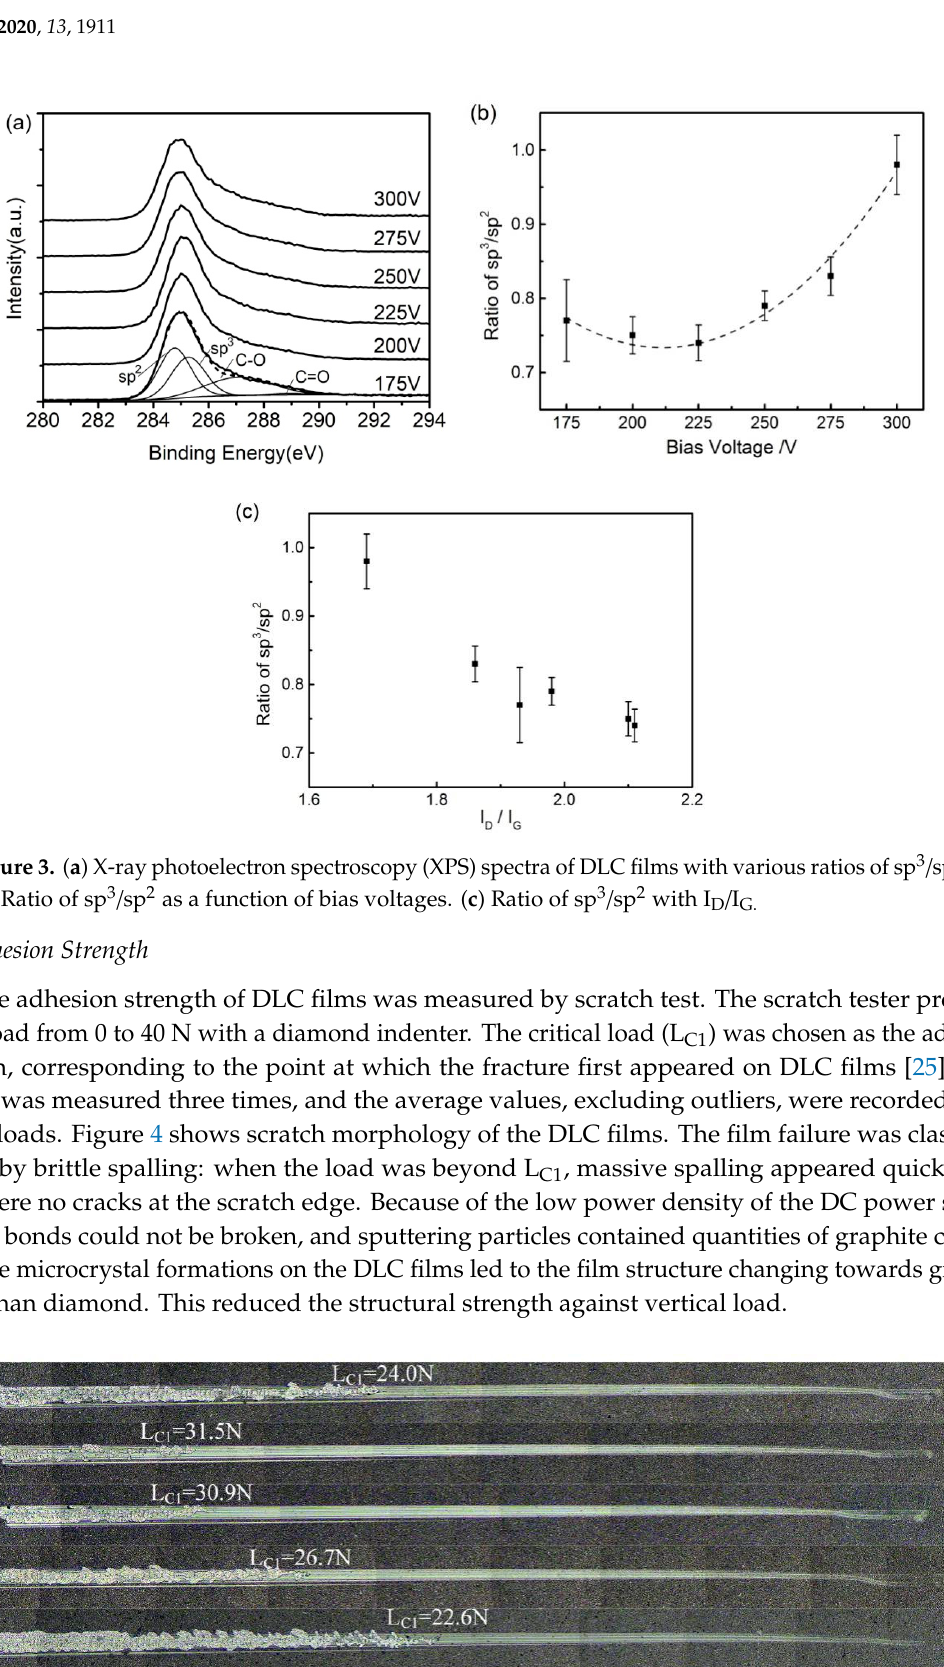
Figure 2. ( a ) Raman spectra of DLC films with various ratios of sp 3 /sp 2 . ( b ) Gaussian fi tting results for Raman spectra.